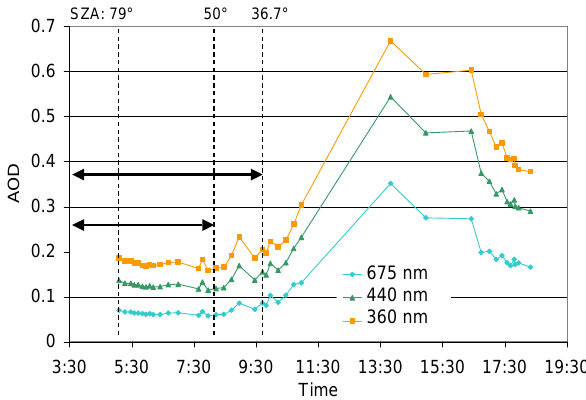
Figure 1. AOD derived from sun photometer observations (AERONET) at Cabauw at three wavelengths. The black vertical lines indicate the start of the AERONET measurements (05:06, SZA: 79 ◦ ) and the ends of the two measurement periods used in this study: 03:30–08:05 (SZA: 90–50 ◦ ); 03:30–09:41 (SZA: 90–36.7 ◦